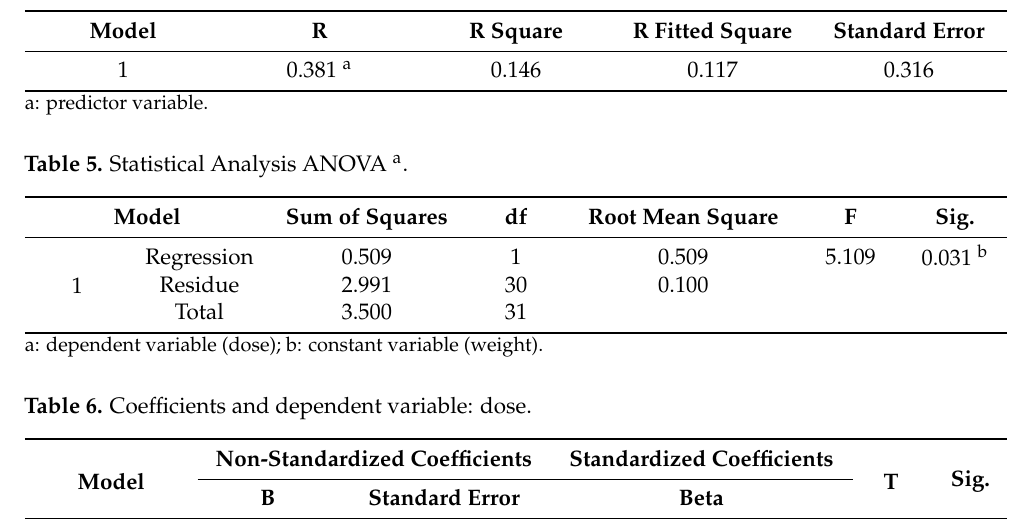
Table 4. Regression between weight and dose.